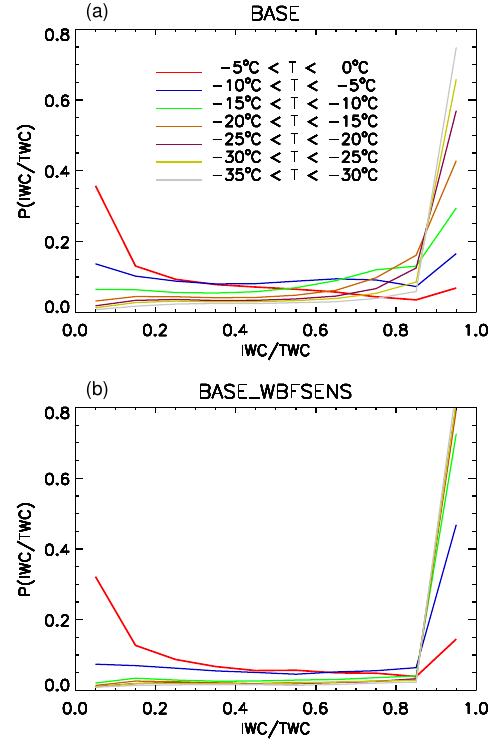
Fig. 13. As Fig. 9 for the BASE and the WBFSENS sensitivity